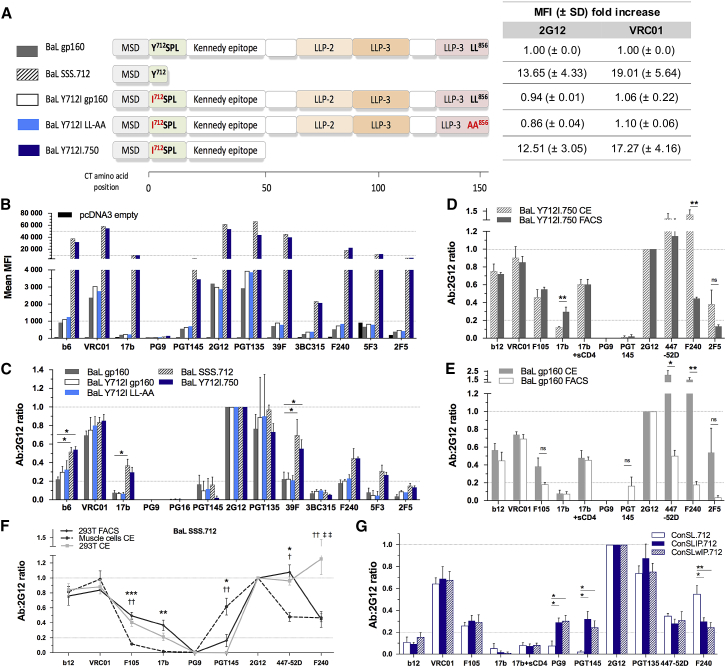
The Adhesion Status, Cellular Host Model, and Cytoplasmic Tail of Env Affect the Epitope Presentation(A) Comparison of the BaL gp160 and modified BaL Env CT. Mutation of the recycling/endocytosis motifs are indicated in red. The impact on expression levels is reported as mean MFI (± SD) fold increase over BaL gp160 (n ≥ 2).(B) Mean MFI values of Env surface expression assessed by FC, representative of n ≥ 2 independent experiments.(C) mAb:2G12 ratios as in Figure 2 (n ≥ 2).(D and E) Comparison of mAb:2G12 ratios obtained from 293T.17 Cell ELISA (CE) and FC using (D) BaL Y712I.750 and (E) BaL gp160 (n = 3).(F) Comparison of BaL SSS.712 epitope profile in muscle cell CE, 293T.17 CE, and FC (n ≥ 2).(G) Muscle cell CE mAb:2G12 of ConSL.712, ConSLIP.712, and ConSLVD.712 (n ≥ 3).For all of the graphs, error bars represent means ± SEMs. One-way ANOVA with Sidak’s multiple comparisons. ∗p < 0.05, ∗∗p < 0.01, ∗∗∗p < 0.001 for (C), (F), and (G), where each sign in (F) compares ∗muscle cells versus 293T.17 FC, †muscle cells CE versus 293T.17 CE, and ‡293T.17 FC versus 293T CE. Unpaired t test for (D) and (E). FACS, fluorescence-activated cell sorting; LLP, lentiviral lytic peptide domains; MSD, membrane-spanning domain; ns, not significant; SSS, secretion signal sequence. See also Figures S1A, S3, S4, and S5.